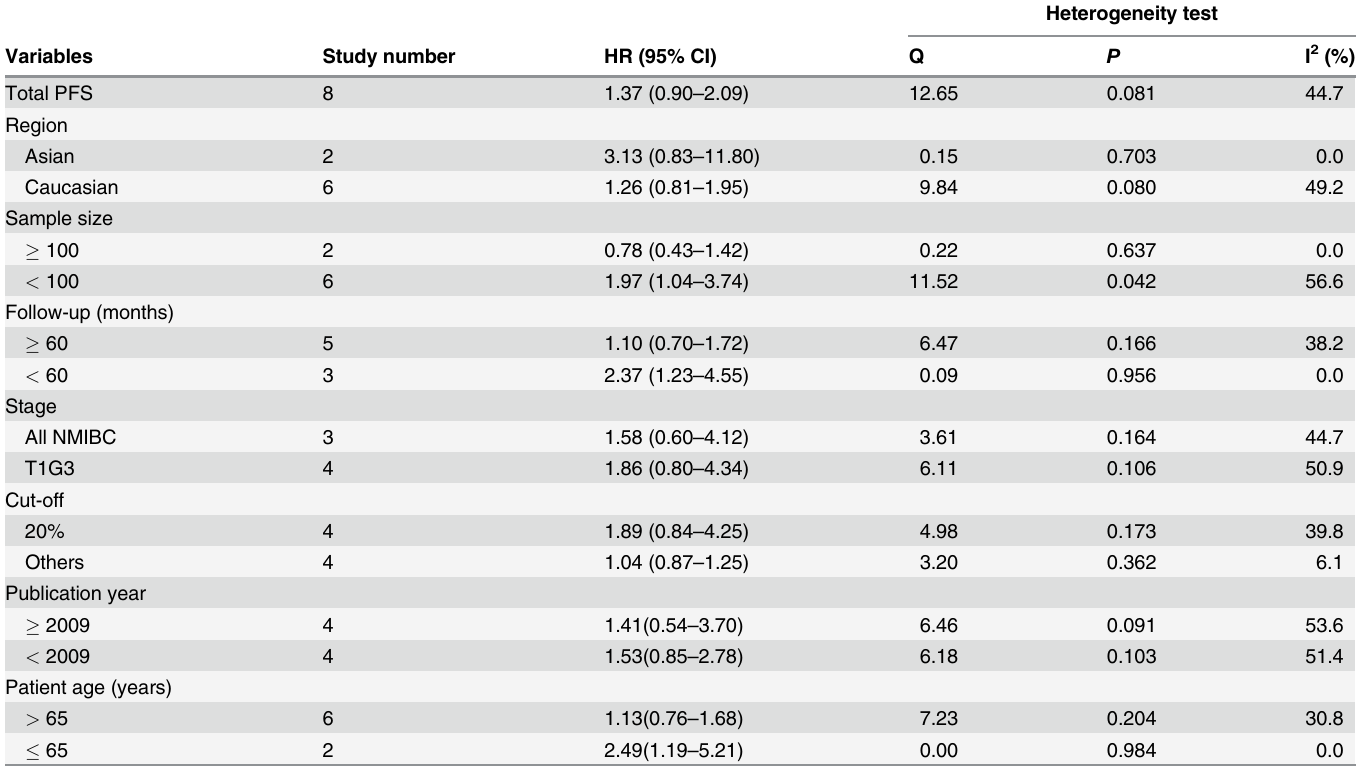
Table 3. Subgroup results of PFS and heterogeneity